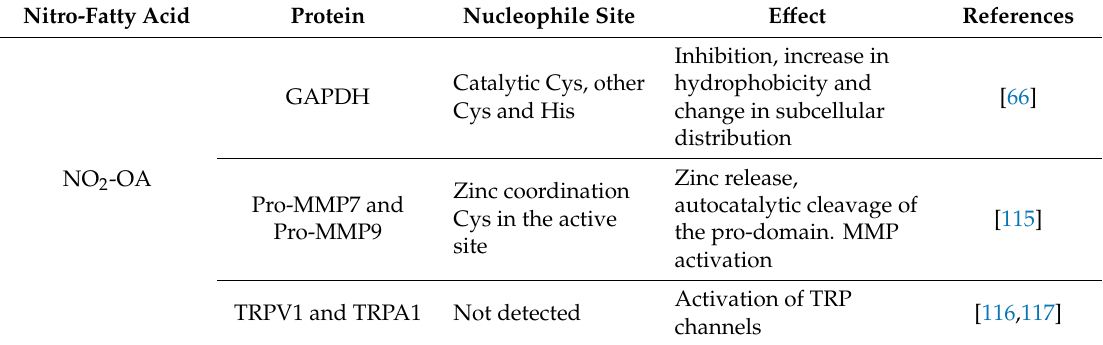
Table 2. NO 2 -FA protein targets in animal systems and their e ff ects on protein function (modified from Reference